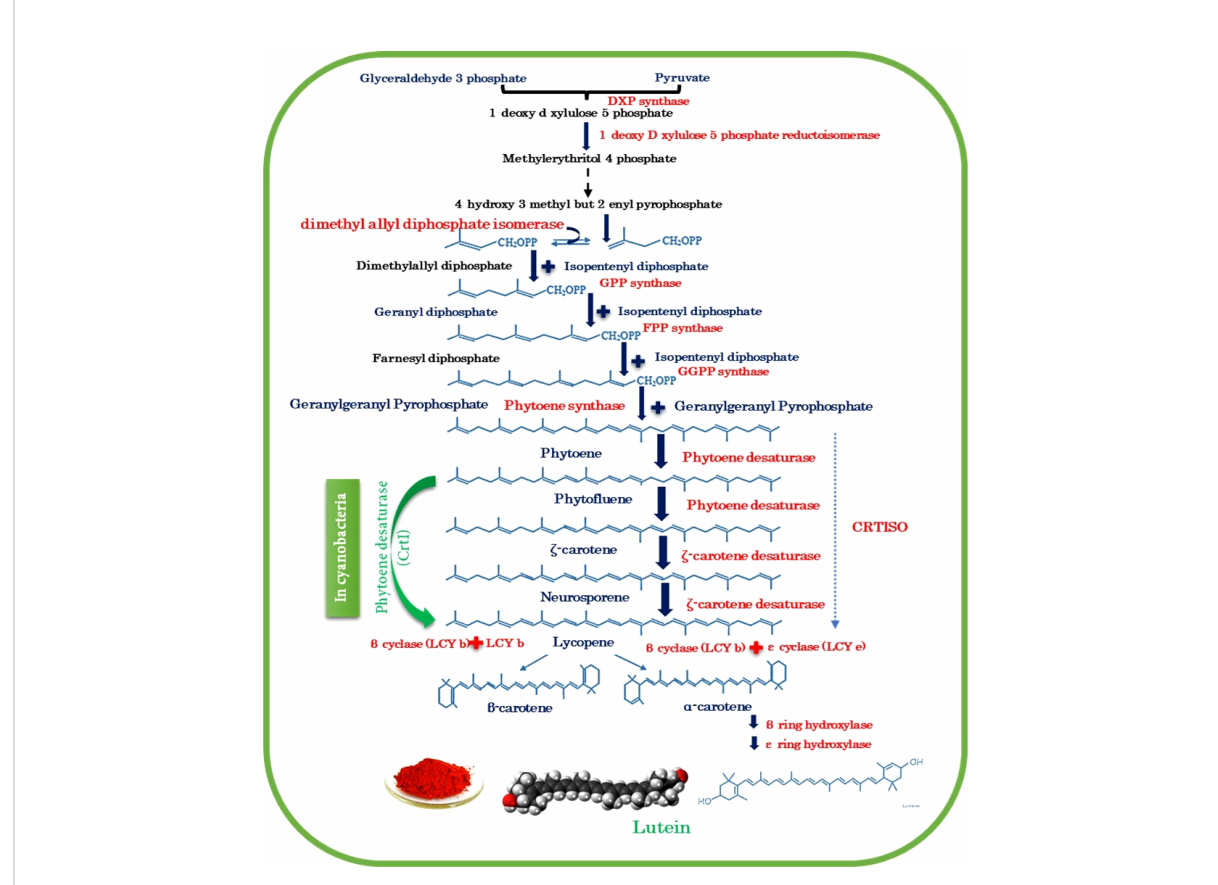
FIGURE 1 Biosynthetic pathway of lutein in microalgae; source references (Huang et al., 2021; Kato et al., 2021; Lou et al., 2021; Xie et al., 2021; Song et al., 2022; Velmurugan and Kodiveri Muthukaliannan,